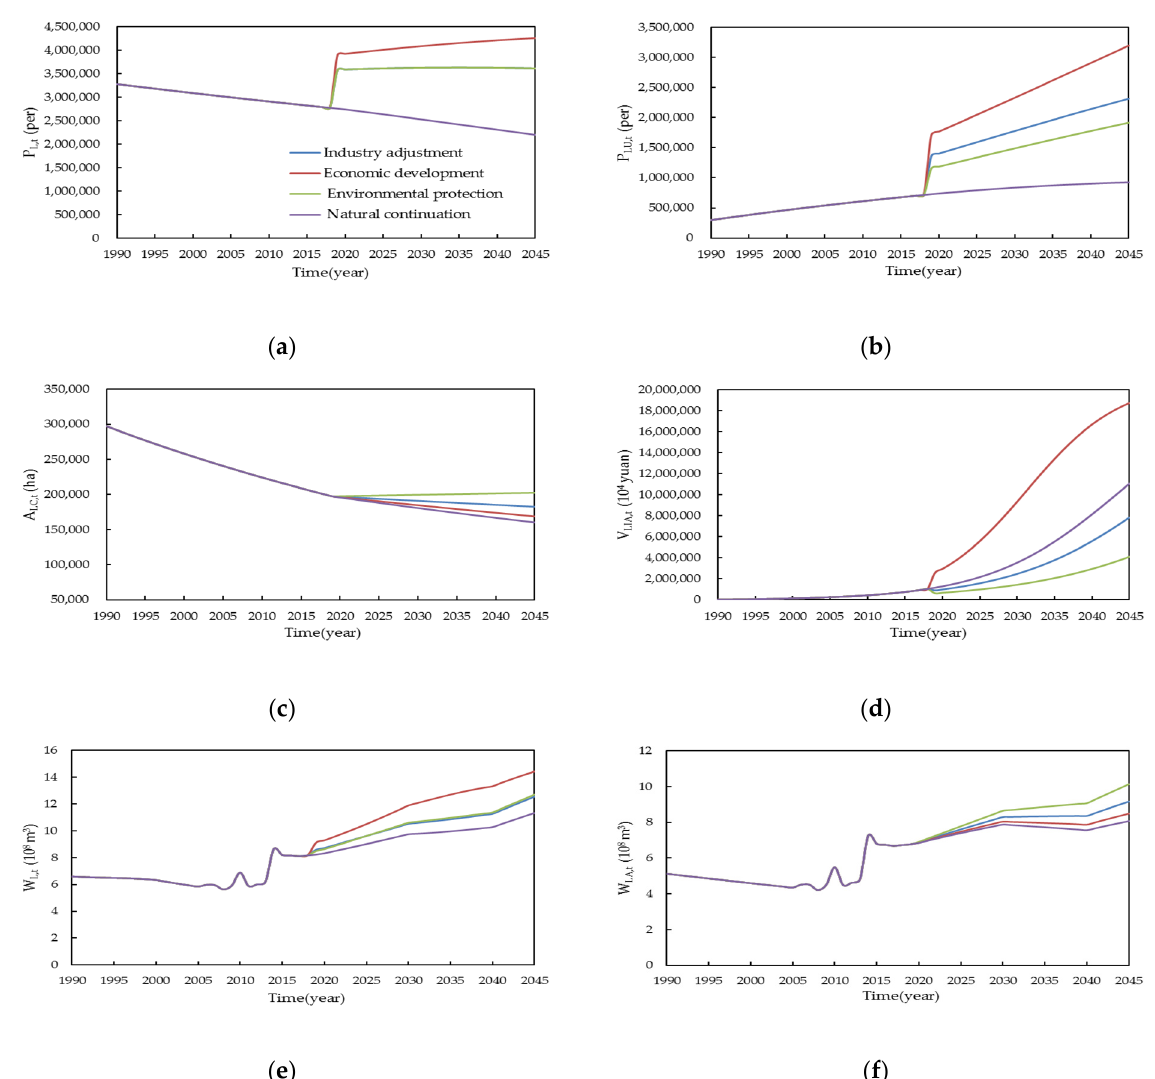
Figure 4. The future evolution of the main variables in the upper section. ( a ) Population in the upper section, ( b ) urban population in the upper section, ( c ) cultivable land area in the upper section, ( d ) industrial added value in the upper section, ( e ) water consumption in the upper section, ( f ) agricultural water consumption in the upper section, ( g ) tertiary industry water consumption in the upper section, ( h ) domestic water consumption in the upper section, (i) industrial water consumption in the upper section, ( j ) environmental water consumption in the upper section.